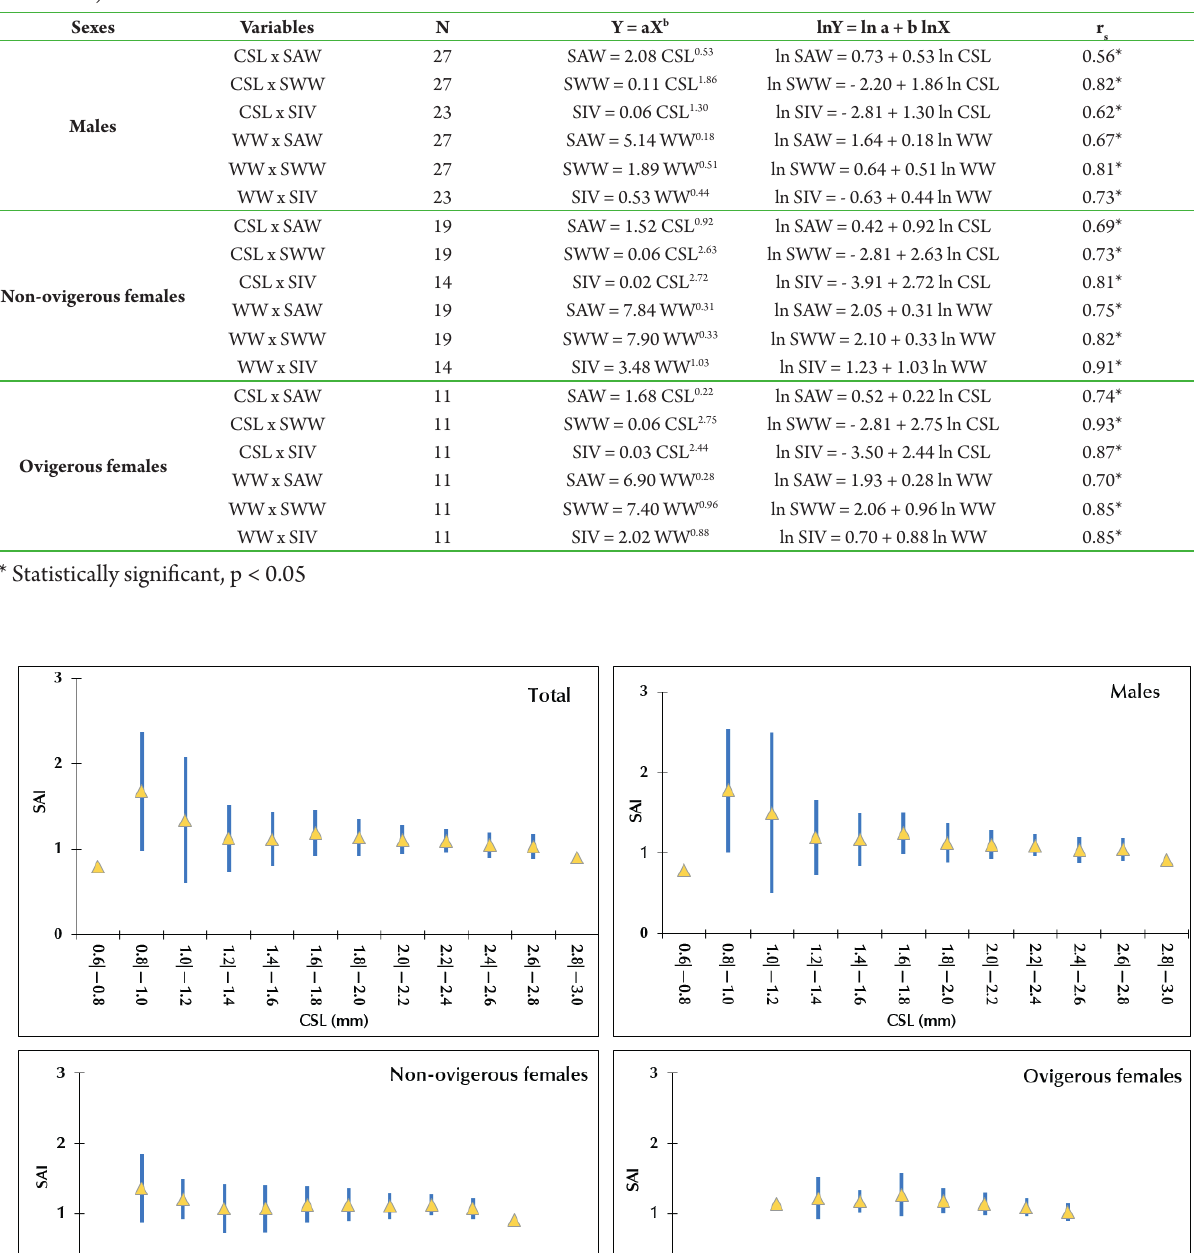
Table 5. Pagurus criniticornis . Regression equations for measures between hermit crab and the shells of Cerithium atratum chosen under laboratory conditions, according to sexes. (CSL = Cephalothoracic Shield Length; WW = hermit crab Wet Weight; SAW = Shell Aperture Width; SWW = Shell Wet Weight; SIV = Shell Internal Volume; N = number of individuals; r